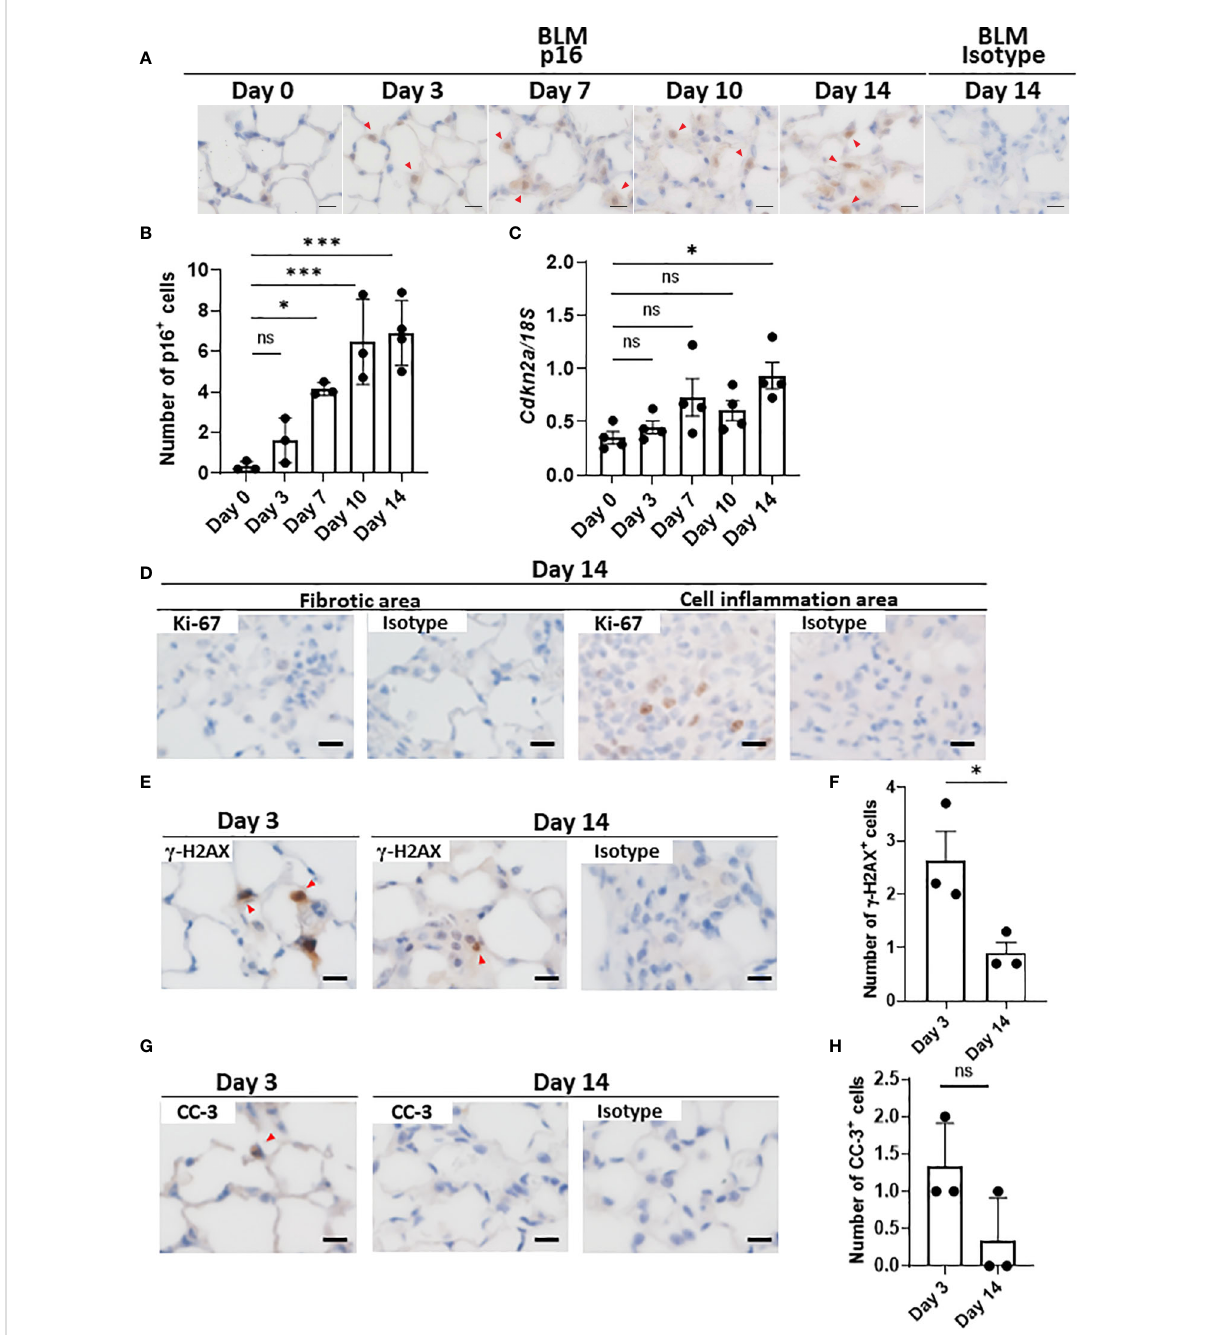
FIGURE 3 AEC2 in BLM-ILD express other cellular senescence markers.Paraf fi n-embedded lung tissue was prepared as described in Figure 1. (A) Representative images of immunohistochemical staining for p16INK4A on the indicated days. (B) Numbers of p16INK4A+ cells per area of the right lung from pooled mice. p16INK4A+ cells were counted in 10 randomly selected areas (180 × 120 µm) and the average was plotted. n = 3 – 4 per day. (C) Cdkn2a expression relative to 18S rRNA in the lungs of pooled mice by qRT-PCR. n = 4 per day. (D – H) Immunohistochemical analysis of Ki-67 (D) , g -H2AX (E, F) , and cleaved caspase-3 (CC-3, G, H ) in the lungs of mice 3 and/or 14 days after the instillation of BLM. The numbers of g -H2AX+ (F) cells per area or the total number of CC-3+ (H) cells in 10 areas were plotted as described in Figure 1E. Red arrows indicate positive cells. Scale bars indicate 5 µm. Data are presented as the mean ± SEM. A one-way ANOVA with Dunnett ’ s multiple comparisons test was used as a post-hoc test comparing values on day 0 (B, C) . Unpaired t-tests were used for two-group comparisons (F, H) . ns, not signi fi cant. *p < 0.05; ***p <